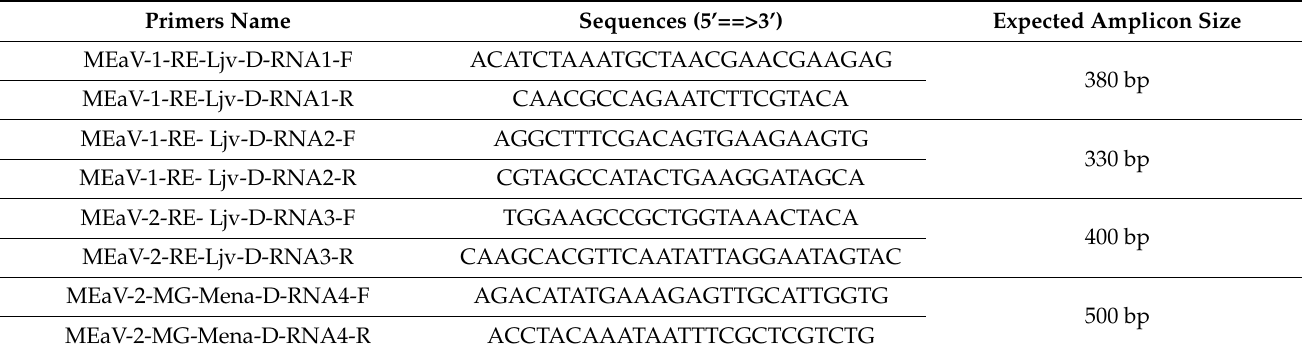
Table 3. RT-PCR primer pairs used for the characterization of the defective RNA